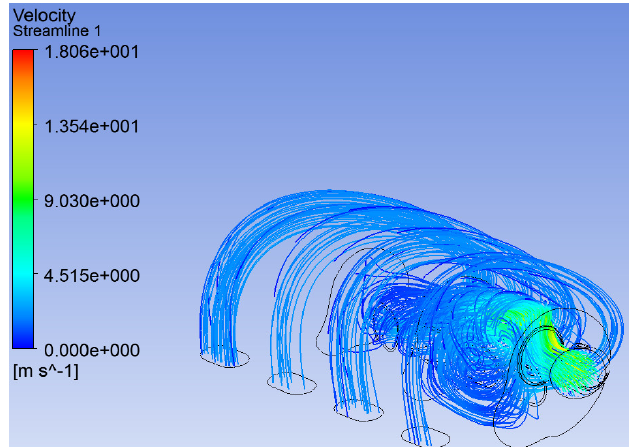
Fig. 9. Steady-state CFD